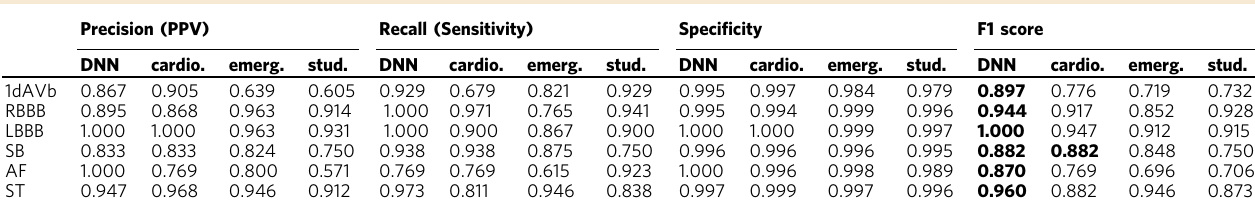
Table 2 (Performance indexes) Scores of our DNN are compared on the test set with the average performance of: (i) 4th year cardiology resident (cardio.); (ii) 3rd year emergency resident (emerg.); and (iii) 5th year medical students (stud.). Precision (PPV) Recall (Sensitivity)